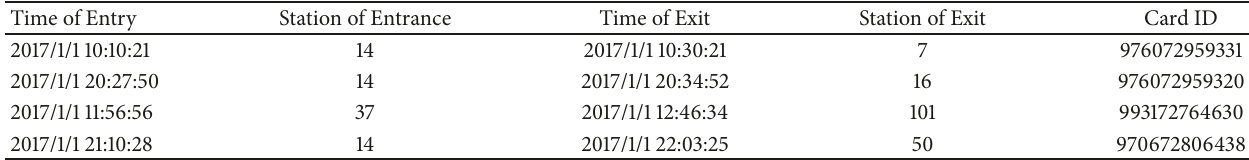
Figure 1: Nanjing metro network. Table 1: Examples of smart card data used in this